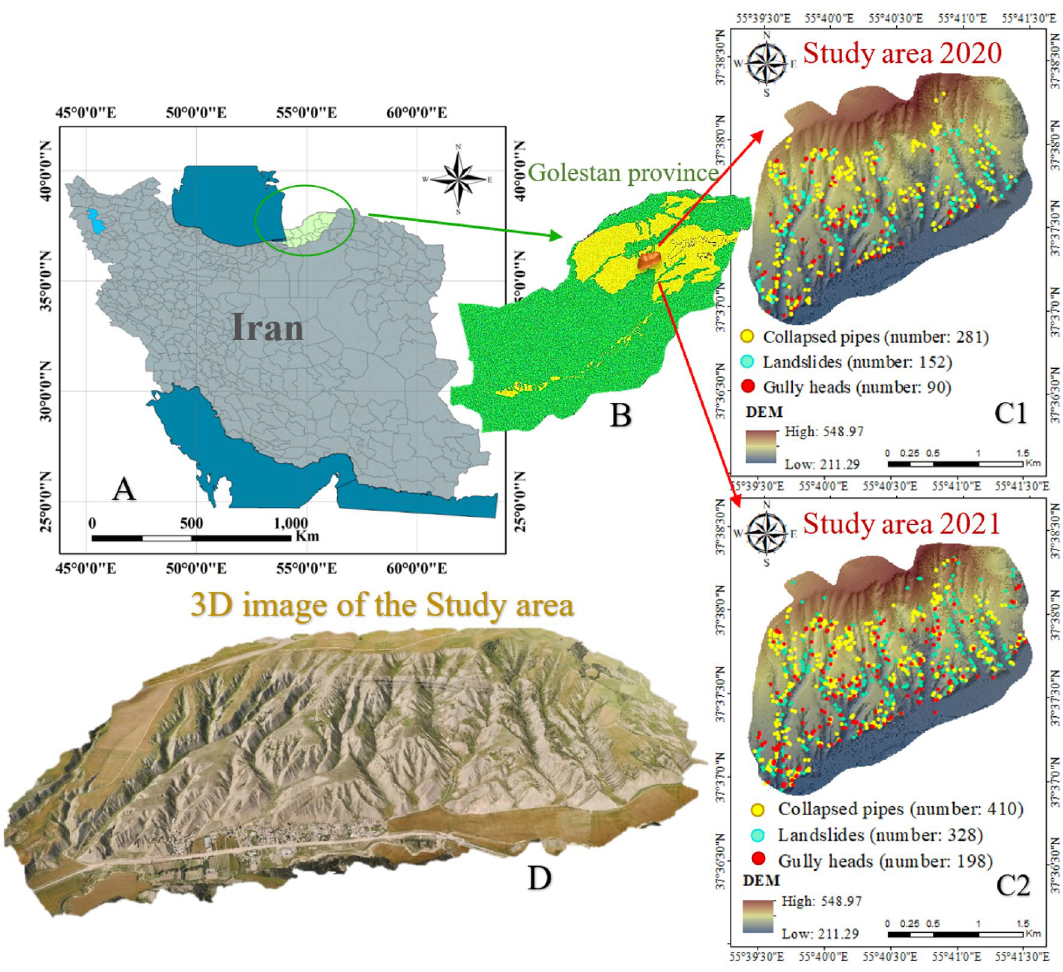
Figure 7. The location of study area in Iran ( A ), Golestan province ( B ), study area in 2020 ( C1 ) and 2021 ( C2 ), and the 3D map of the study area ( D ) prepared using ArcGIS 10.3.1 software (https:// www. esri.